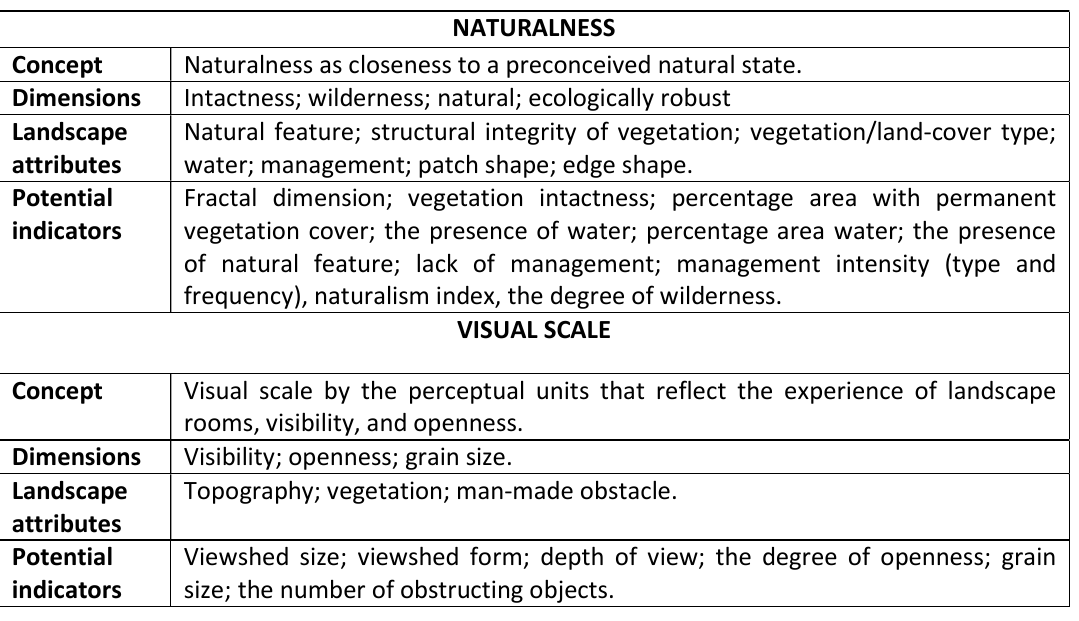
Table 1: Naturalness characteristics of landscapes. Adapted from Tveit et al.